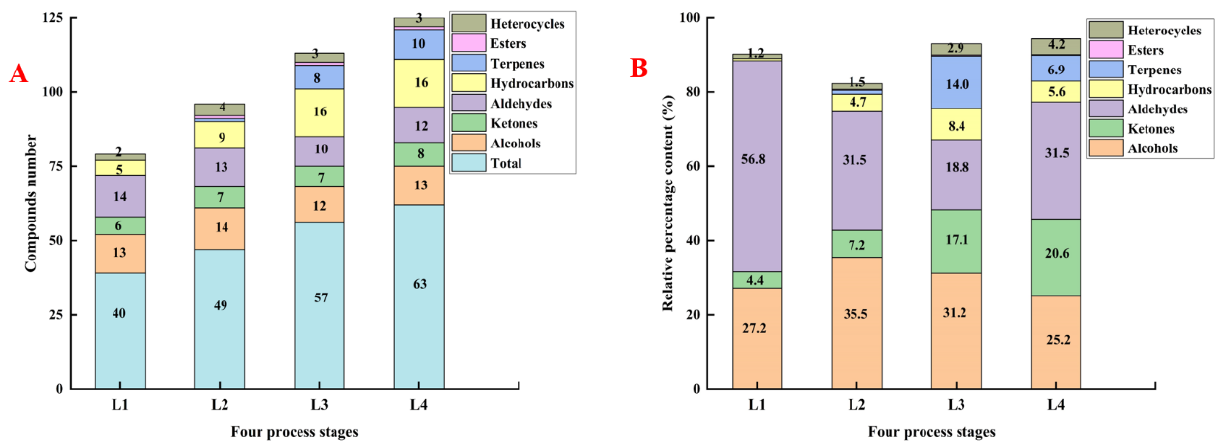
Figure 2. The contents and number of volatile flavor components in Daokou braised chicken during processing. (Note: ( A , B ) refer to the contents and number of volatile flavor components